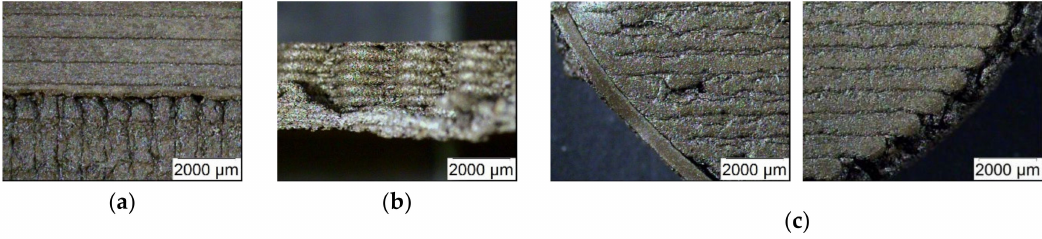
Figure 6. Printing defects observed at a printed composite with 30 vol.% ferrite content: ( a ) top view tensile test specimen, contact between clamping and gauge zone; ( b ) side view tensile test specimen, missing envelope; ( c ) top view magnetic specimen with voids and incompletely filled